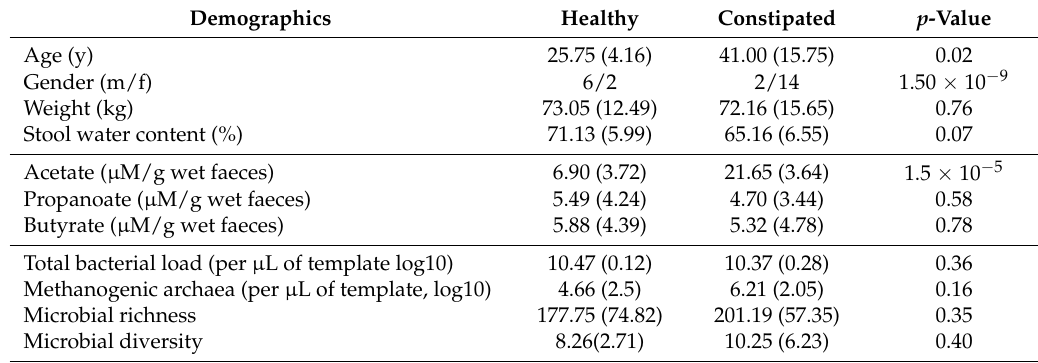
Table 1. The patient demographics and amount of short chain fatty acids and microbial content at baseline. The standard deviations for each number show in